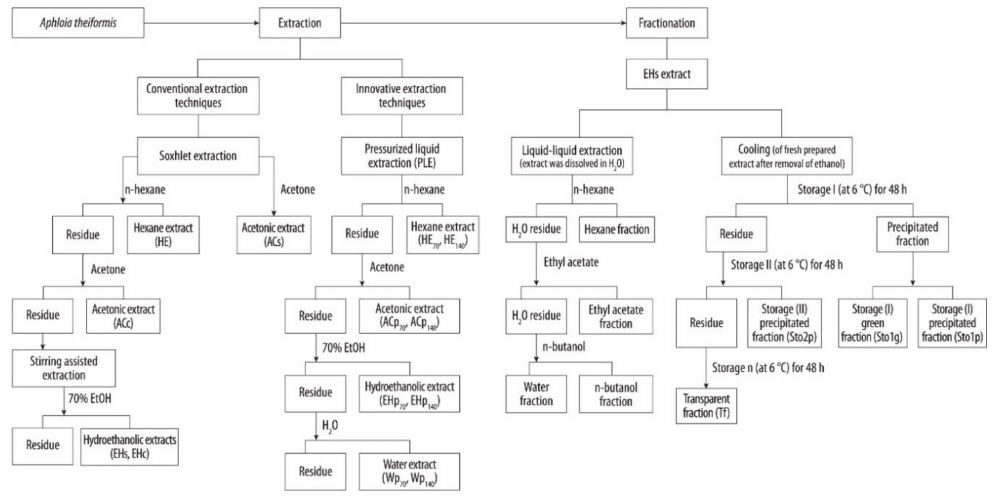
Figure 1. Schematic representation of extraction and fractionation procedure of A. theiformis